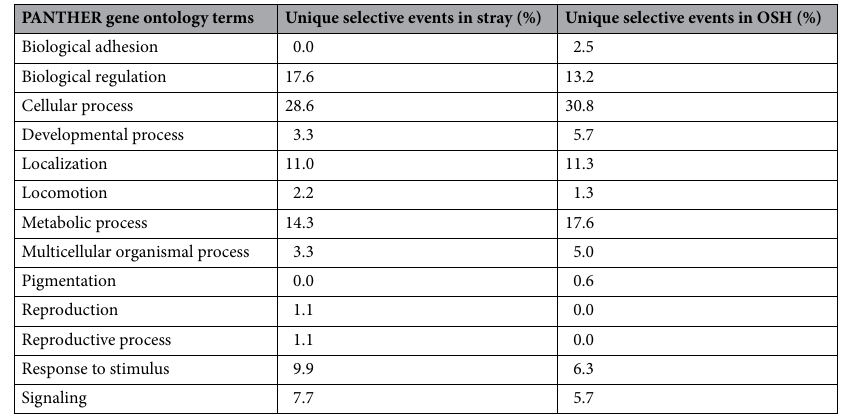
Table 9. Functional annotations in unique selective events. PANTHER gene list analysis (http:// www. panth erdb. org/) was performed for genes in unique selective regions in stray and OSH, respectively. The percent of gene hits against total number of process hits involved in specific biological processes are shown.